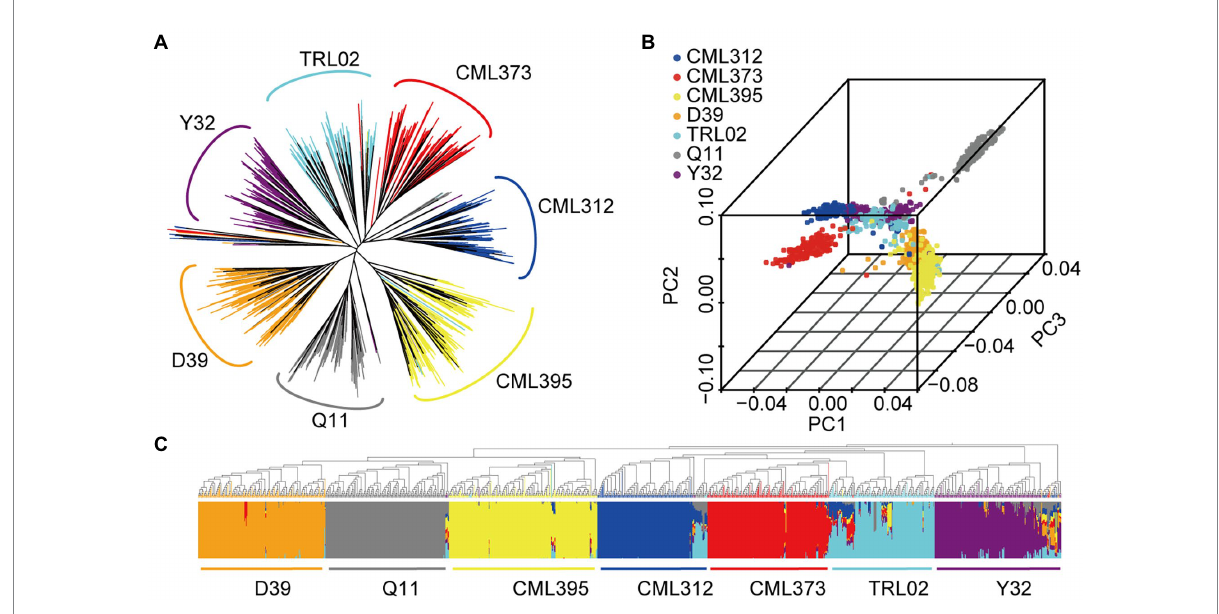
FIGURE 4 Phylogenetic tree (A) , principal component analysis (B), and genetic structure (C) of the 1,215